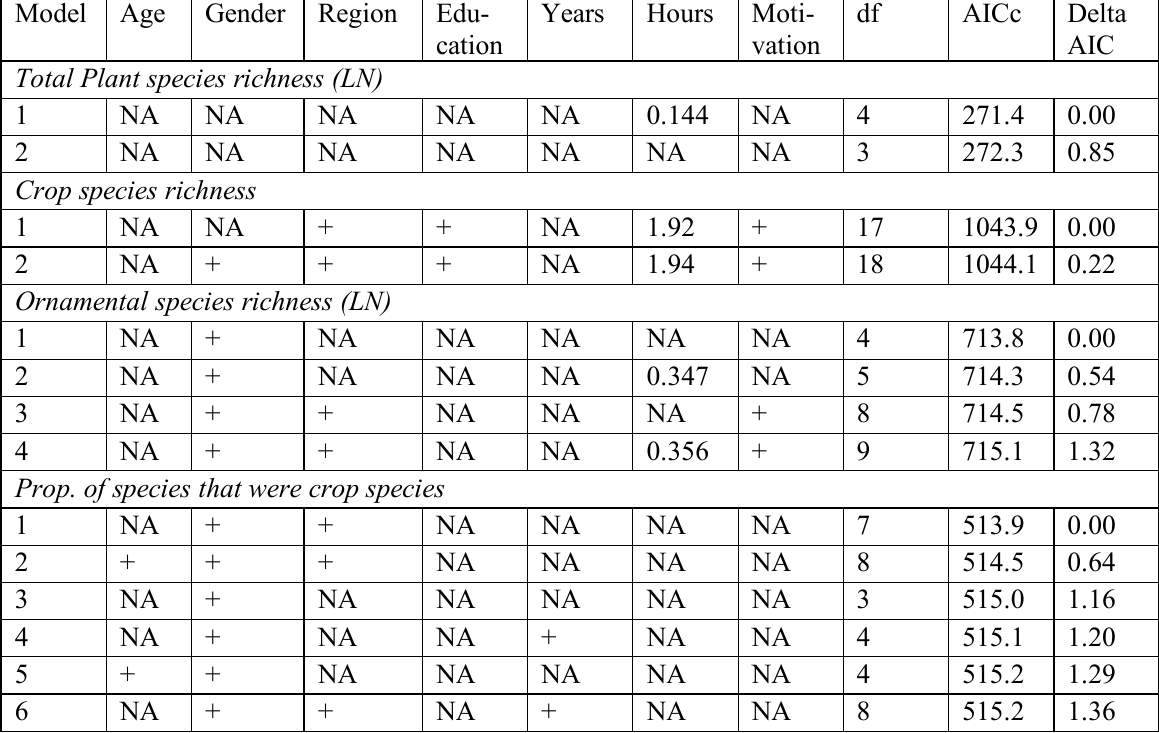
Table A3.1. Results of GLMM model selection for models examining relationships between gardener socio-demographic factors, gardening experience, and motivations for gardening and plant species richness, crop species richness, and ornamental plant species richness. All models within two AIC points of the top model are shown and were included in average models. Garden was included as a random effect for all models. A plus (+) indicates a factor was included in that model, NA indicates the factor was not included in that